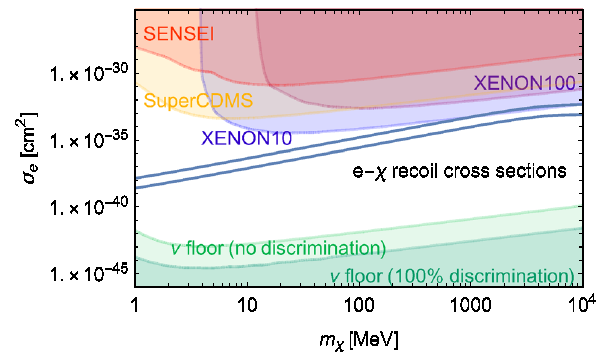
Fig. 2 The electron recoil cross section as a function of dark matter mass m χ in the range 1MeV ≤ m χ ≤ 10GeV. The lower curve is for a e = 0 and the upper curve is for a 2 e = a 2 m . The neutrino floors with and without full separation of electron-neutrino and nucleon-neutrino scattering are taken from Ref. [65]